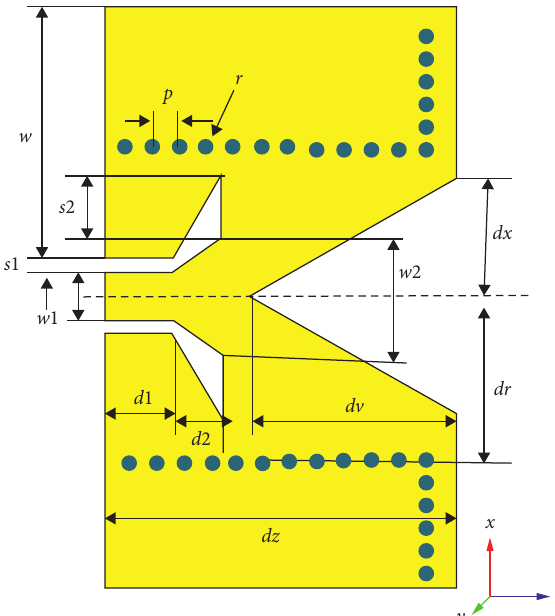
Figure 8: Feeding structure ( w � 11.35, w 1 � 1.3, w 2 � 3.2, s 1 � 0.8, s 2 � 1.8, d 1 � 2, d 2 � 1.4, dv � 5.6, dx � 3.4, dz � 10.4, dr � 3.6, p � 0.8, and r � 0.3. Unit: mm).